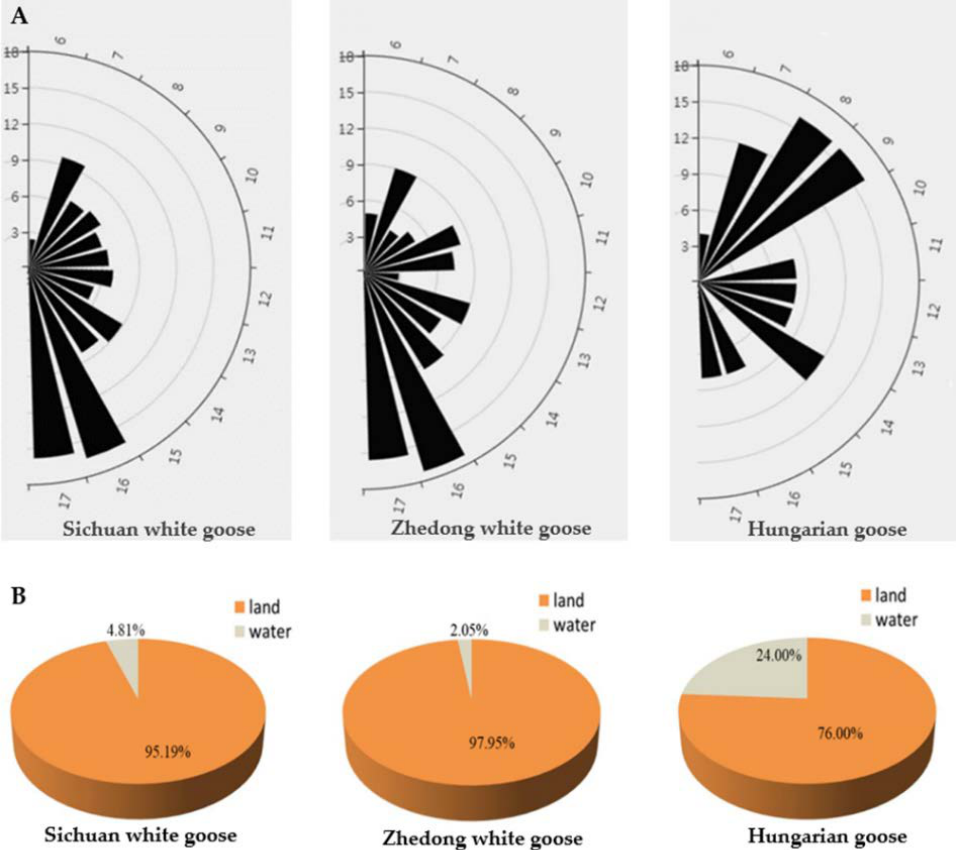
Figure 1. The characteristics of the mating time and location among Sichuan white geese, Zhedong white geese, and Hungarian geese. ( A ) Mating time preferences in the different goose breeds. The vertical numbers were percentages, and the numbers on the semicircle were the hours of the day. ( B ) Note: Mating location preferences in the different goose breeds. The percentages were calculated using the total number of mating over the 20-day period as the denominator.